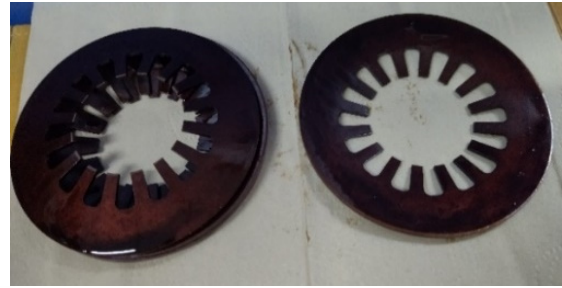
Figure 5. The fabricated slotted disc spring.